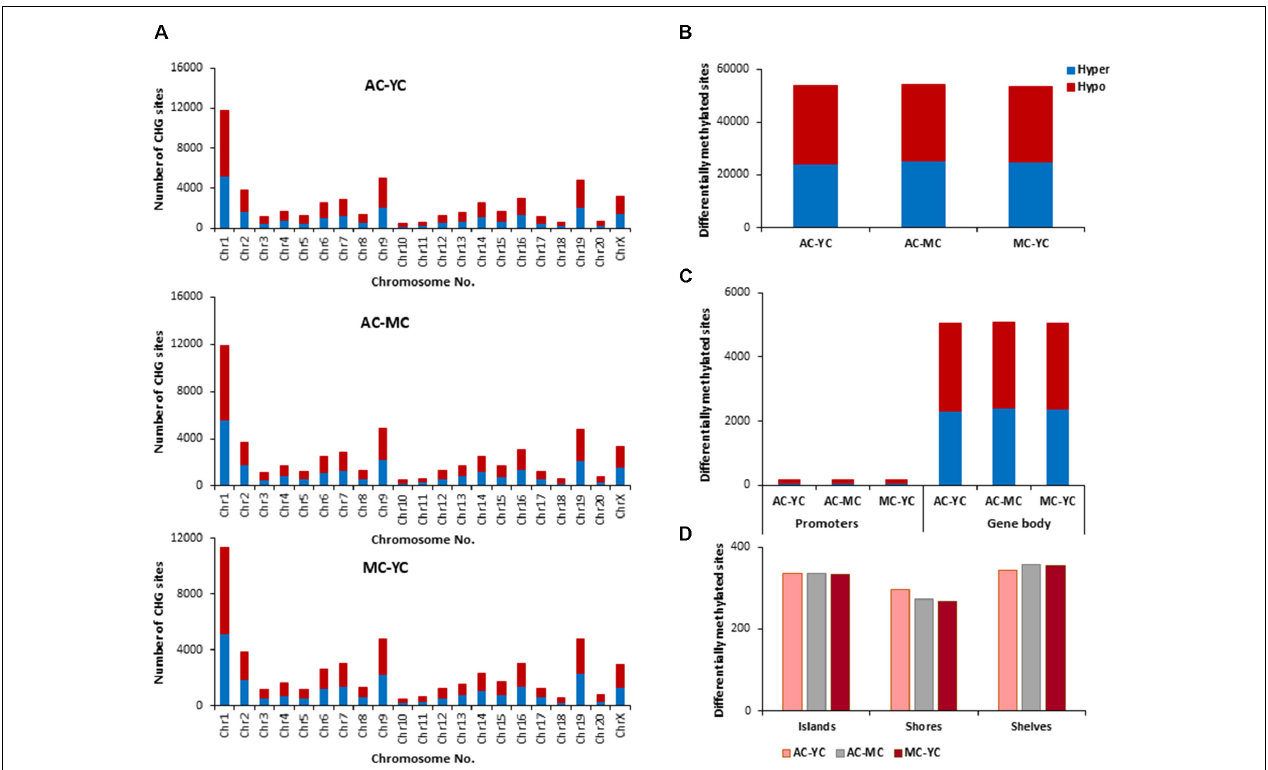
FIGURE 4 | Age-related differences in DNA methylation at CHG sites of control animals. (A) Differentially methylated CHG sites along the chromosome (1–20) including X-chromosome in control groups. The differential methylation was based on a statistical significance of p < 0.01. (B) Total number of differentially methylated CHG sites across the control groups. The red bars denote hypomethylation and blue bar denotes hypermethylation for the older group relative to the younger group. (C) Age differences in the number of differentially methylated CHG sites in promoter and gene body regions. (D) Comparison of the differentially methylated CHG sites across the regulatory regions: islands, shores, and